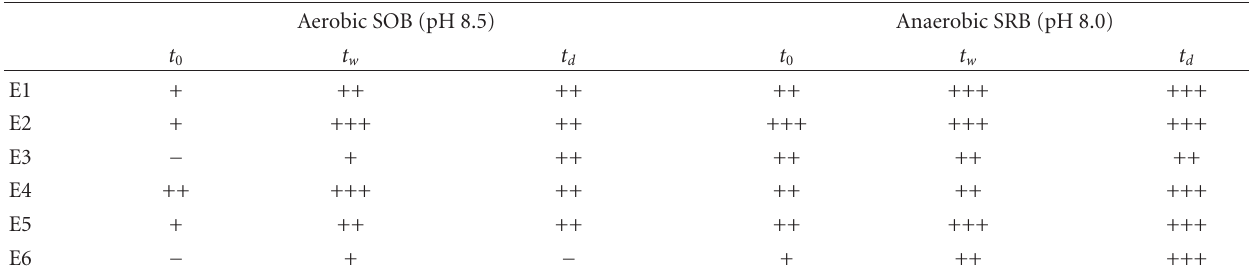
Table 3: Relative abundance of the sulfur-oxidizing bacteria (SOB) and of the sulfate reducing bacteria (SRB) before the assay ( t 0 ) and in the columns after the wet ( t w ) and dry ( t d ) seasons, per